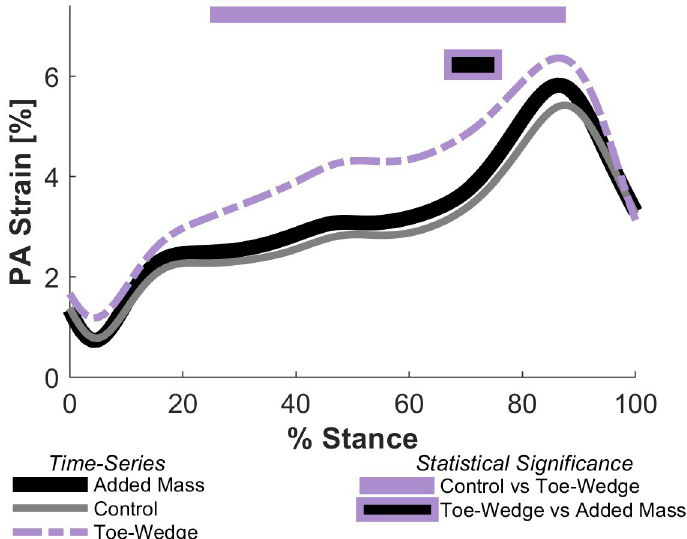
Fig 4. Plantar aponeurosis (PA) strain. Time-series profile of strain in the PA during stance for the added mass, control, and toe-wedge conditions. The shortest length at which there was tension in the PA for each participant was found using the mean of the shortest recorded PA lengths in each trial. The horizontal bars indicate timing of statistically significant time-series differences between the toe-wedge and control conditions (top) and between the toe-wedge and added mass conditions (bottom) using two-tailed paired t-tests ( α = 0.017 following Bonferroni